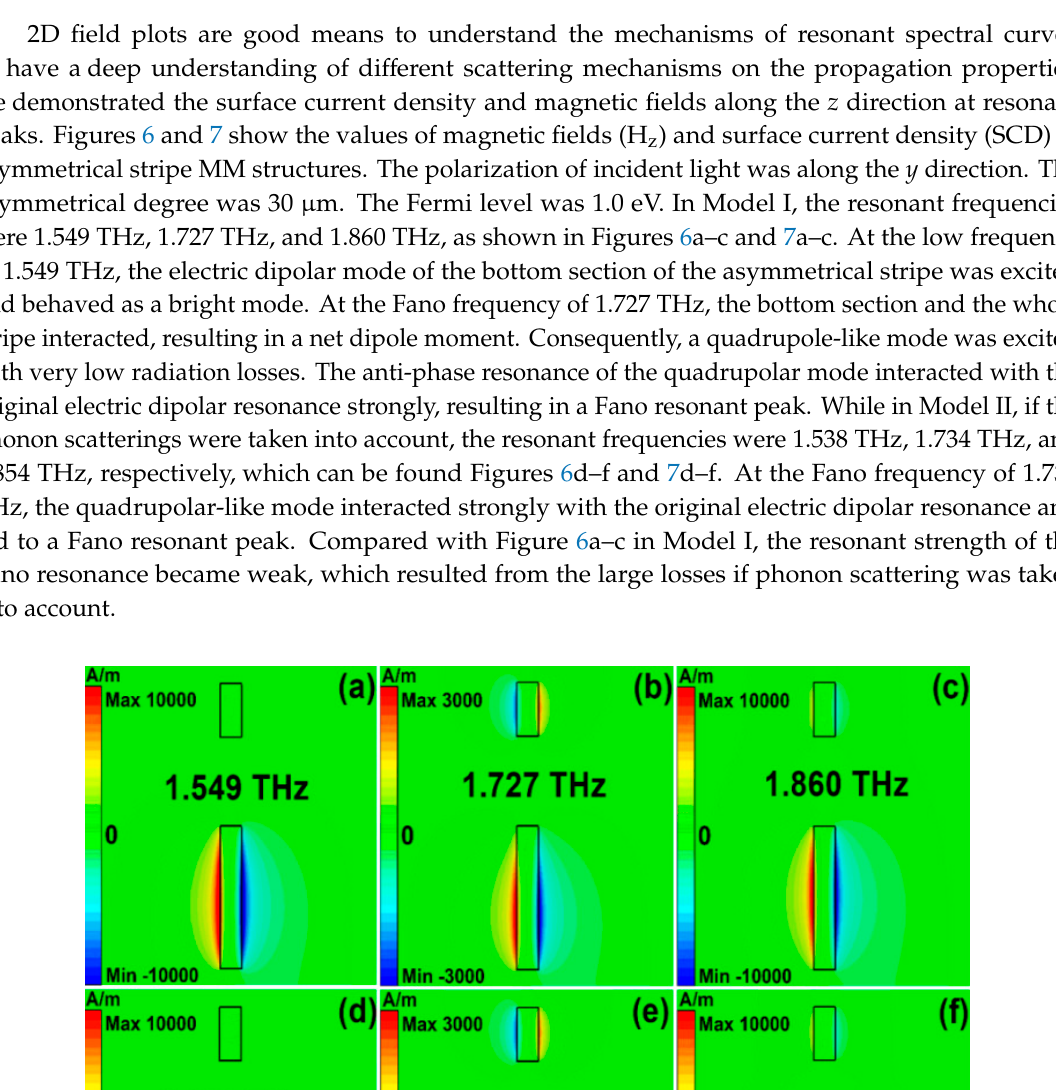
Figure 7. The surface current density for the graphene cut wire stripe patters. ( a–c ) The simulation results for Model I. ( d–f ) The simulation results on condition that the phonon scattering was taken into account. The polarization direction of incident light was along the y direction.